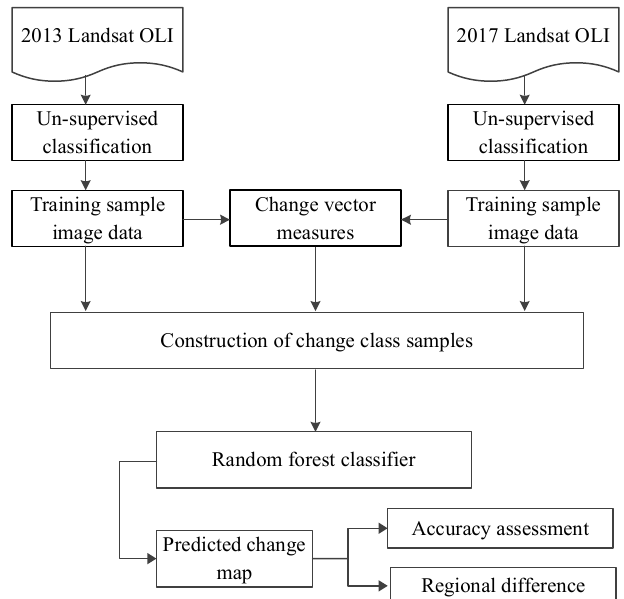
Figure 2. The flowchart of the methods applied in this study.